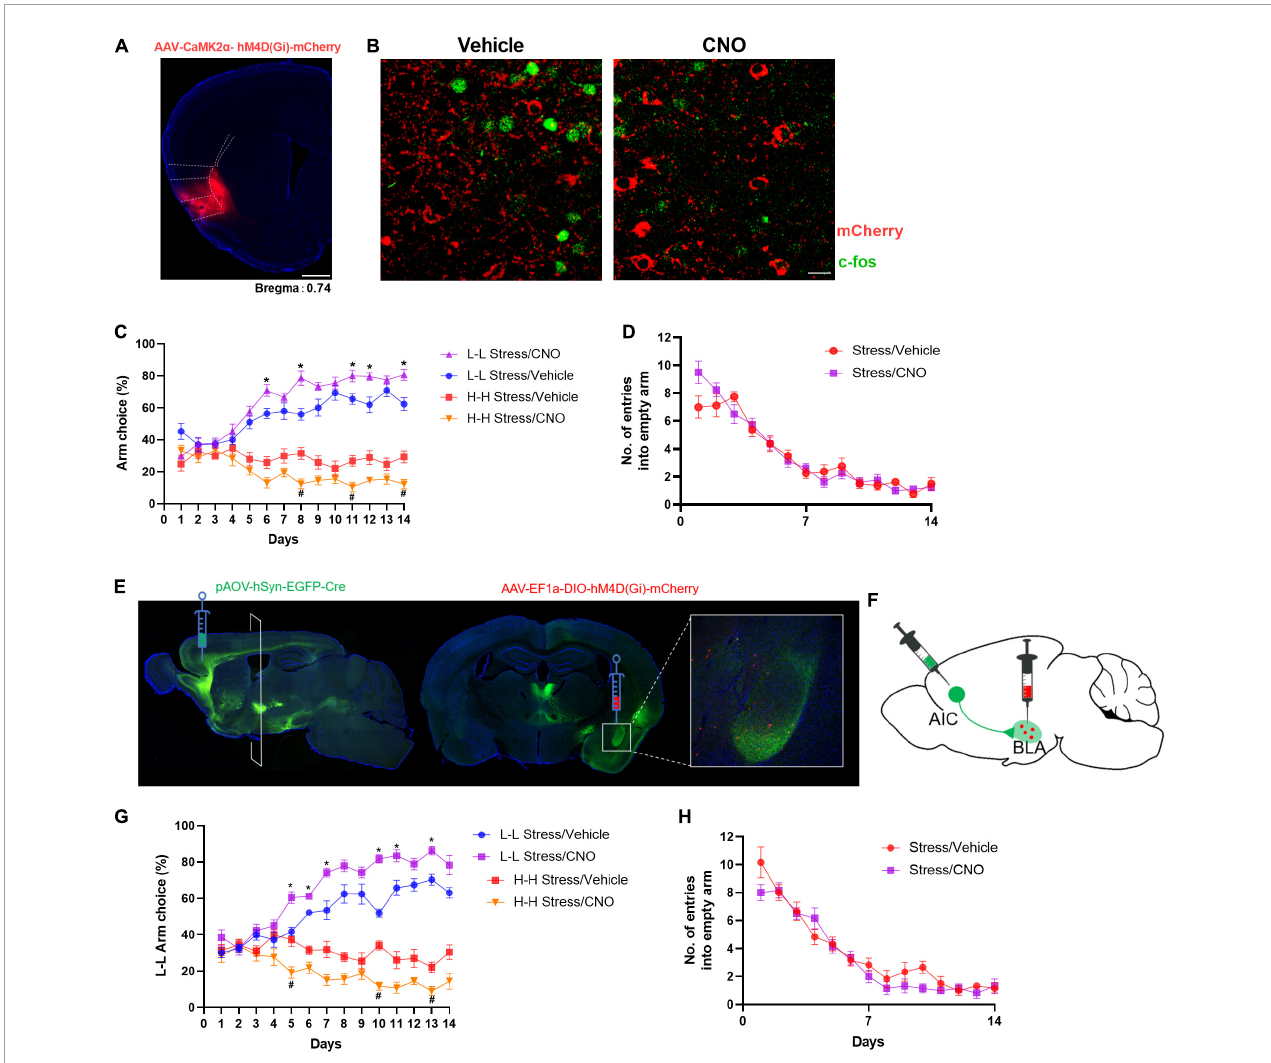
FIGURE3 Chemogenetic inhibition of the AIC-BLA circuit disrupts stress-induced abnormal changes in decision-making behavior. (A) Diagrammatic representation of the expression of hM4Di-mCherry in the AIC. (B) c-Fos expression after CNO treatment in the AIC of hM4Di-overexpressed mice (scale bar: 50 µ m). (C) Effect of AIC inhibition on stress leads to aberrant decision-making behavior. Repeated-measures ANOVA with Bonferroni correction, F ( 3 , 28 ) = 182.3; * P < 0.05 vs. L-L stress/vehicle group ( post-hoc Tukey’s test, P = 0.0475 on day 6, P = 0.0087 on day 8, P = 0.0495 on day 11, P = 0.0370 on day 12 P = 0.0191 on day 14), # P < 0.05 vs. H-H stress/vehicle group ( post-hoc Tukey’s test, P = 0.0078 on day 8, P = 0.0126 on day 11, P = 0.0152 on day 14), n = 8. (D) Effect on the number of entries into empty arms ( F ( 1 , 14 ) = 0.1889, P = 0.6705). (E) Schematic representation of the anterograde virus injection strategy. AIC-projecting neurons were found mainly in the basolateral amygdala (BLA). (F) Schematic picture of selective labeling of BLA neurons innervated by AIC projection. (G) Selectively inhibiting the AIC-BLA circuit can reduce risk-taking behavior of mice. Repeated ANOVA revealed significant effects on treatment [ F ( 1 , 10 ) = 57.86, P < 0.05, n = 6] * P < 0.05 vs. L-L stress/vehicle group ( post-hoc Tukey’s test, P = 0.0041 on day 5, P = 0.0094 on day 6, P = 0.0338 on day 7, P = 0.0001 on day 10, P = 0.0366 on day 11, P = 0.0097 on day 13), # P < 0.05 vs. H-H stress/vehicle group ( post-hoc Tukey’s test, P = 0.0201 on day 5, P = 0.0003 on day 10, P = 0.0279 on day 13). (H) Effect on the number of entries into empty arms ( F ( 1 , 10 ) = 1.668, P =